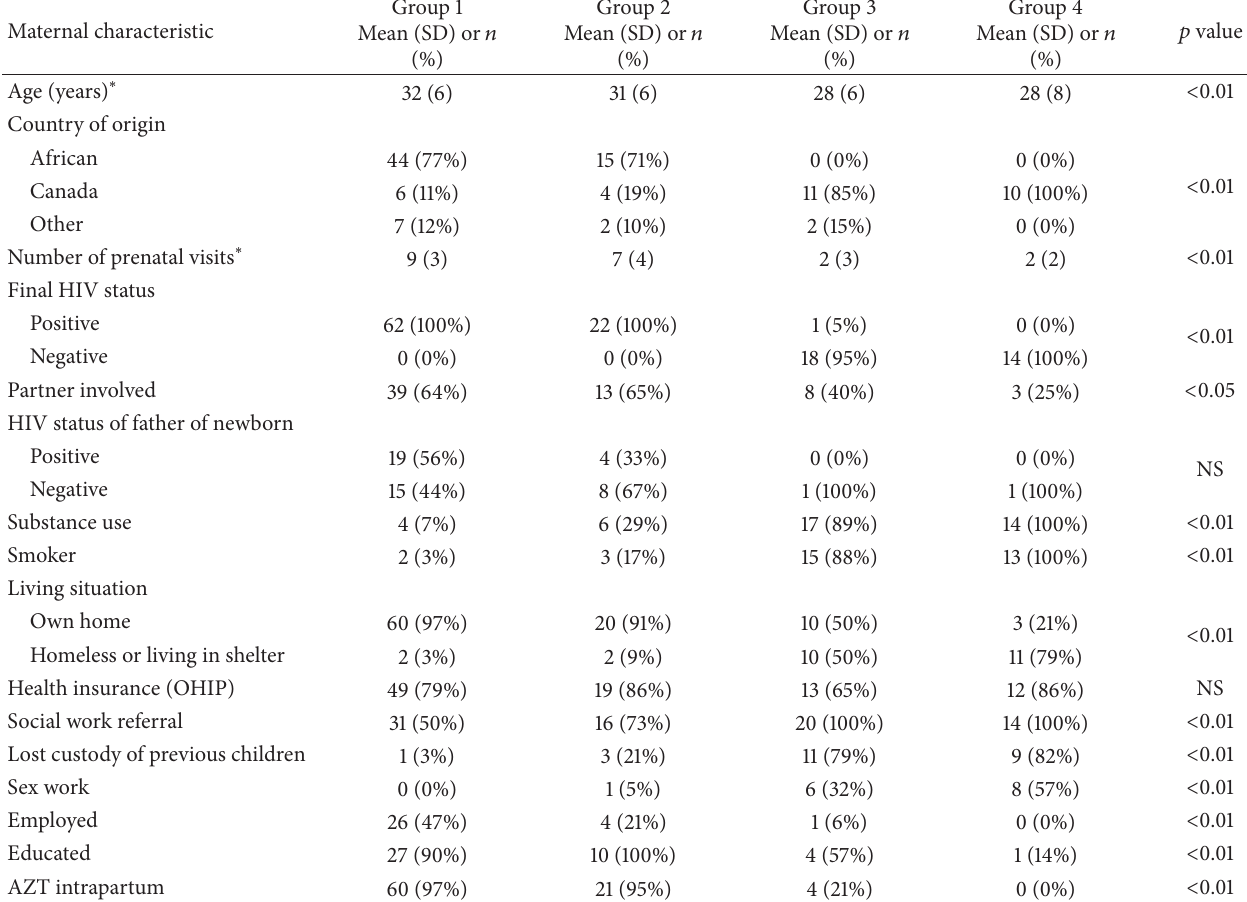
Table 6: Differences in maternal characteristics between 4 groups in secondary